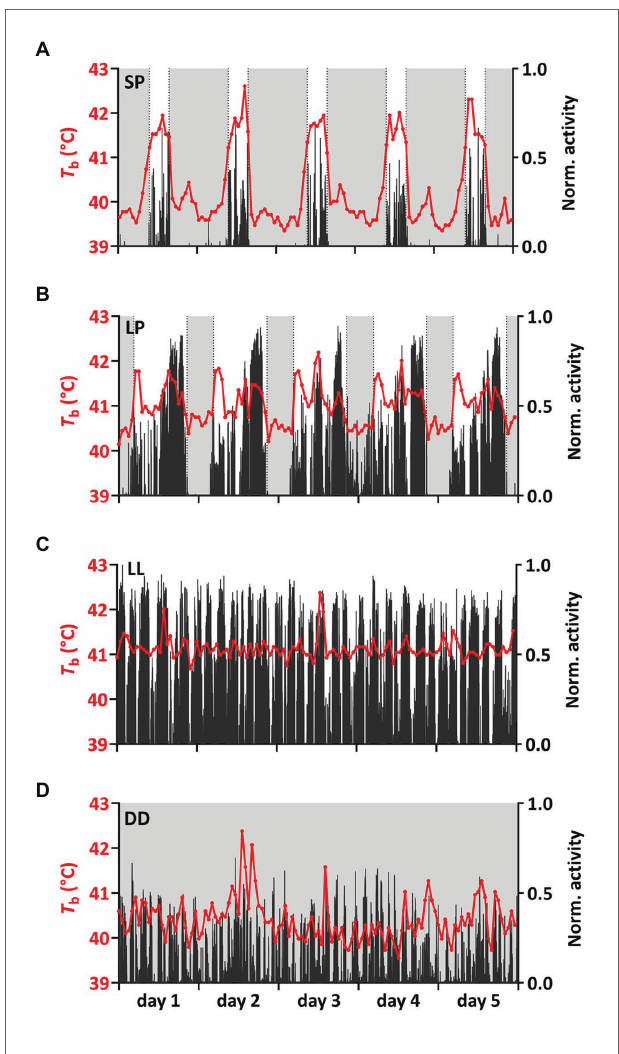
FIGURE 4 | Representative time series for T b and activity. (A–D) T b (red) was plotted together with normalized activity (black) for 5 consecutive days for one representative bird per experimental treatment (bird IDs A : SP6, B,C : LP/LL13, D : DD2). Light gray shadings indicate periods of darkness. Additional time series can be found in Supplementary Figure S4